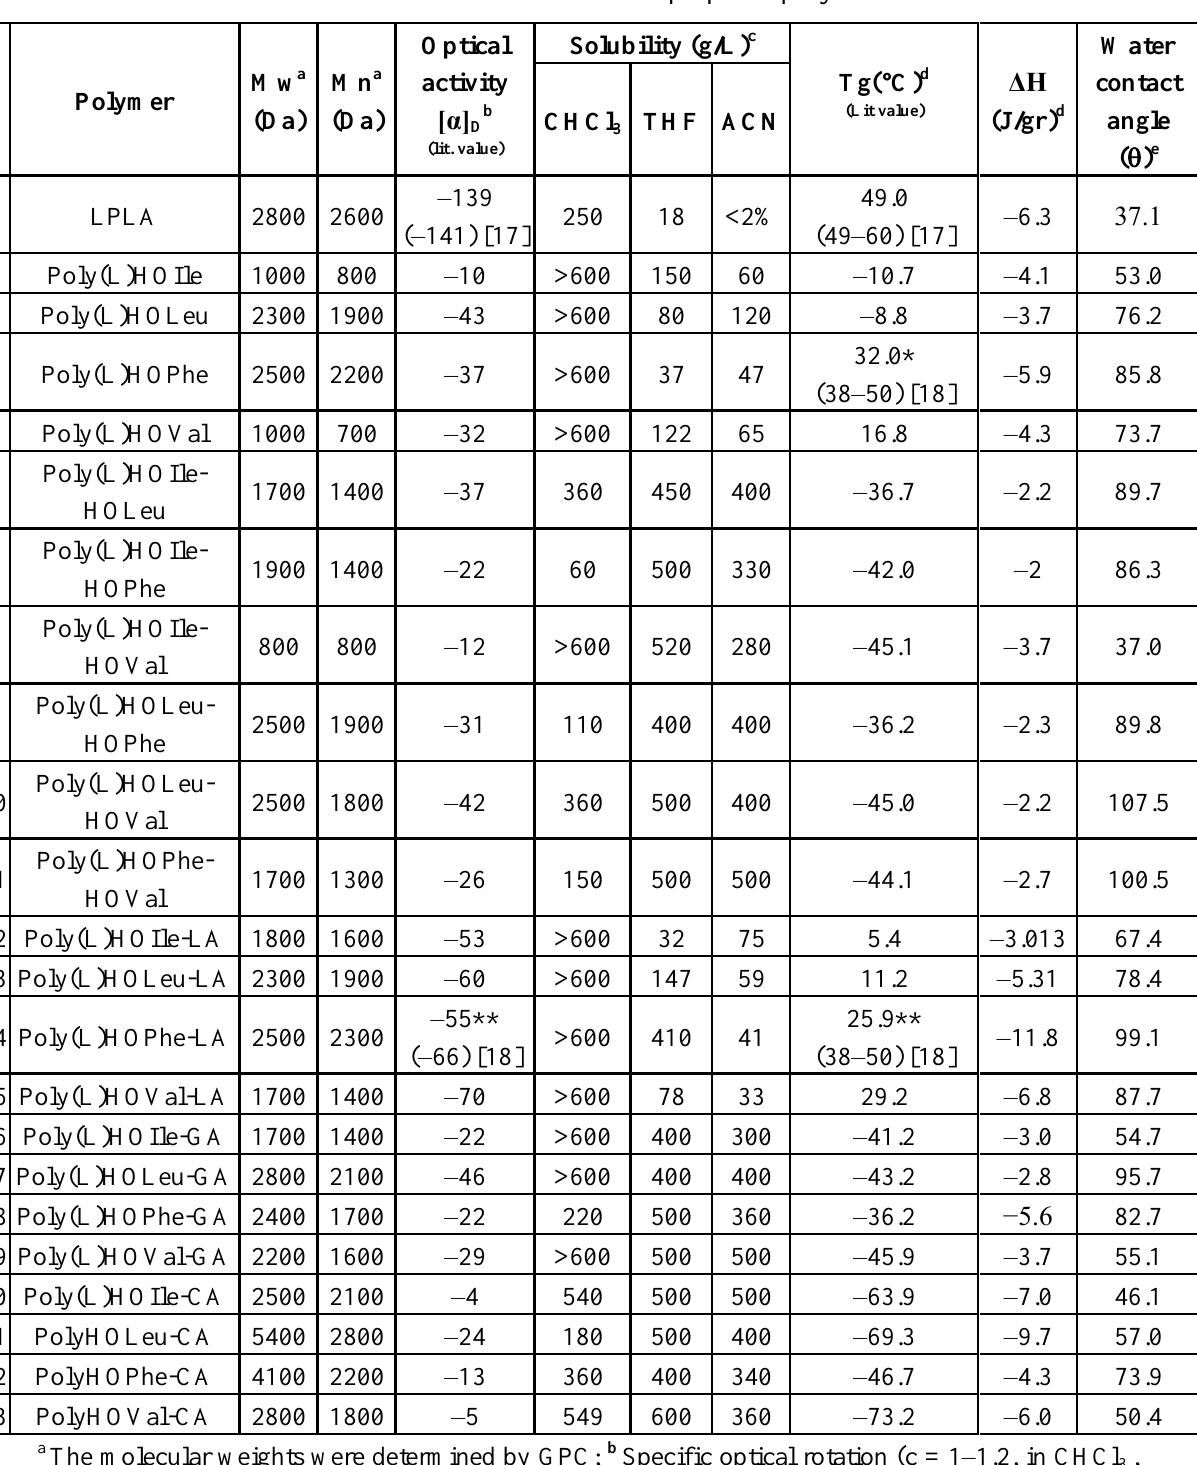
Table 1. Characterization of the prepared